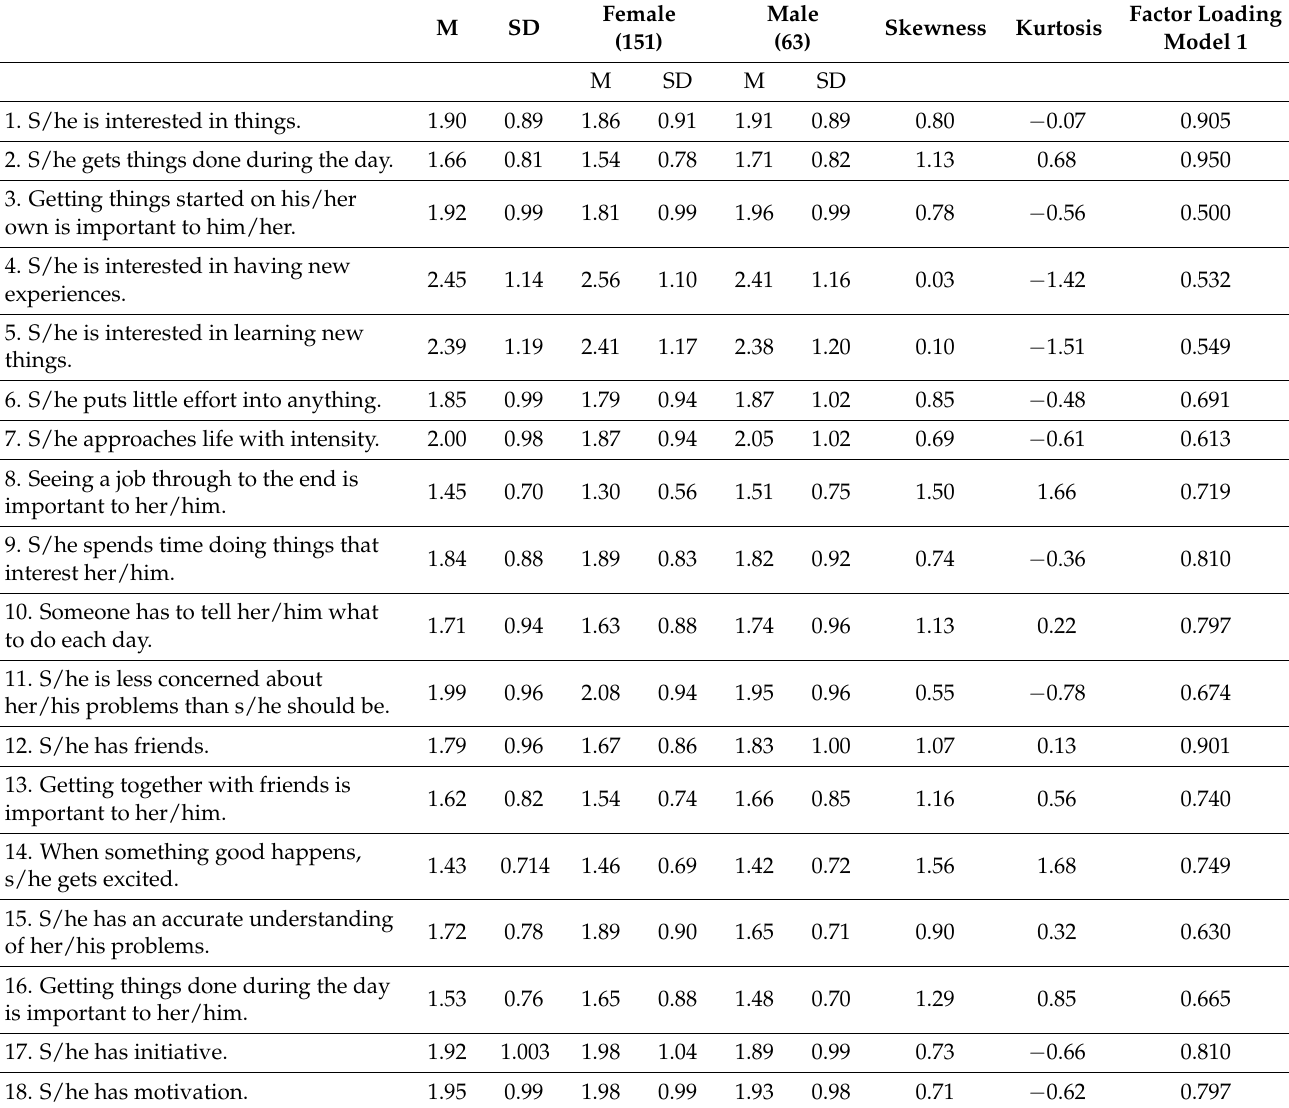
Table 3. Descriptive statistics (mean (M), standard deviation (SD), skewness, kurtosis) and factor loading of model